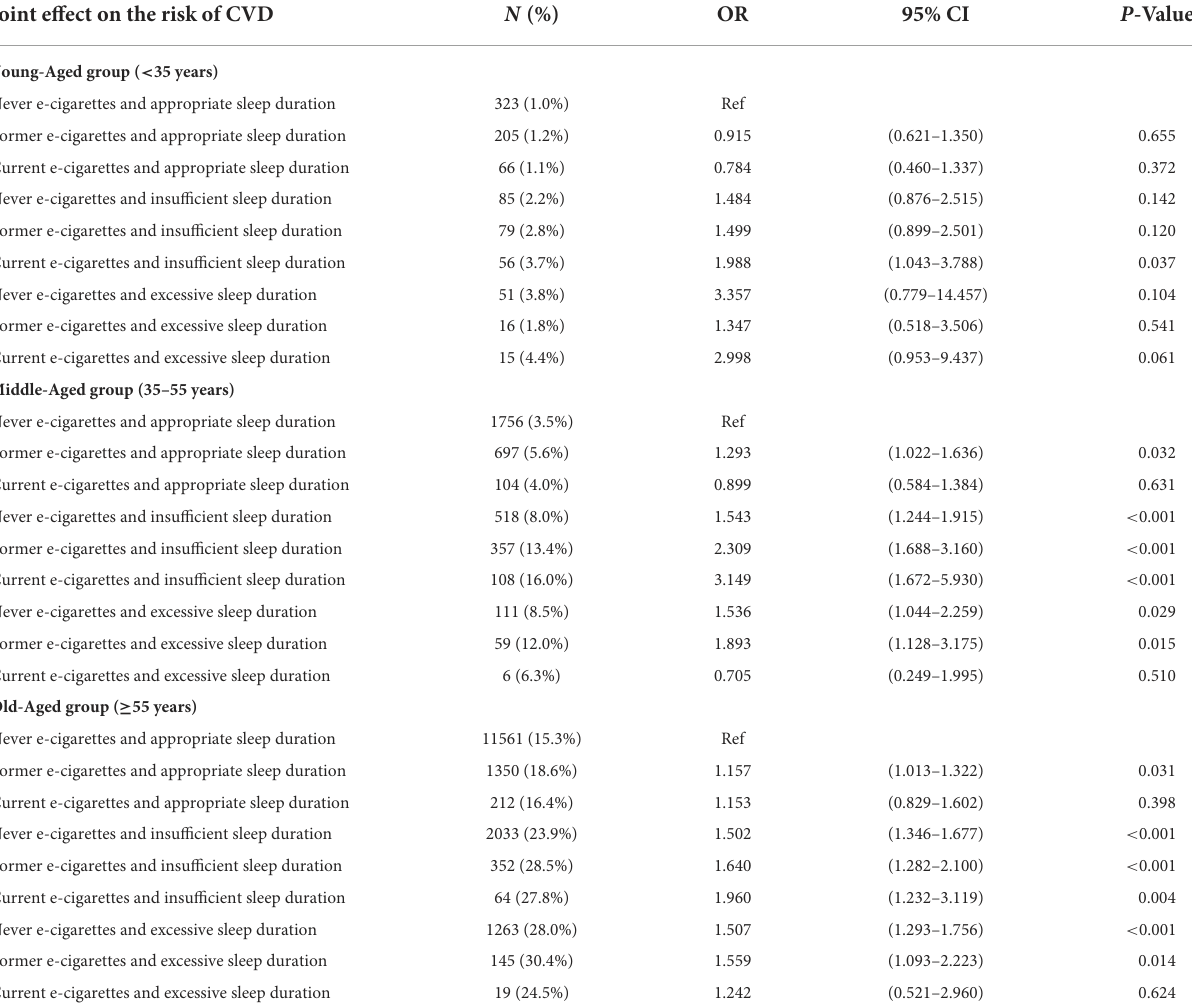
TABLE 3 The joint effect of electronic cigarettes and sleep duration among different age